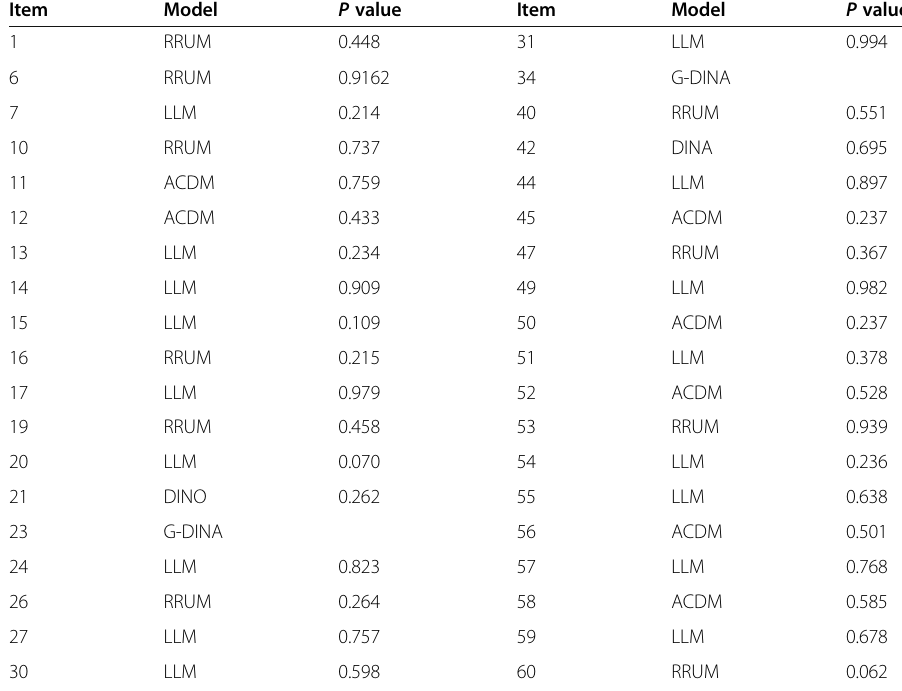
Table 9 Model selection at the item level